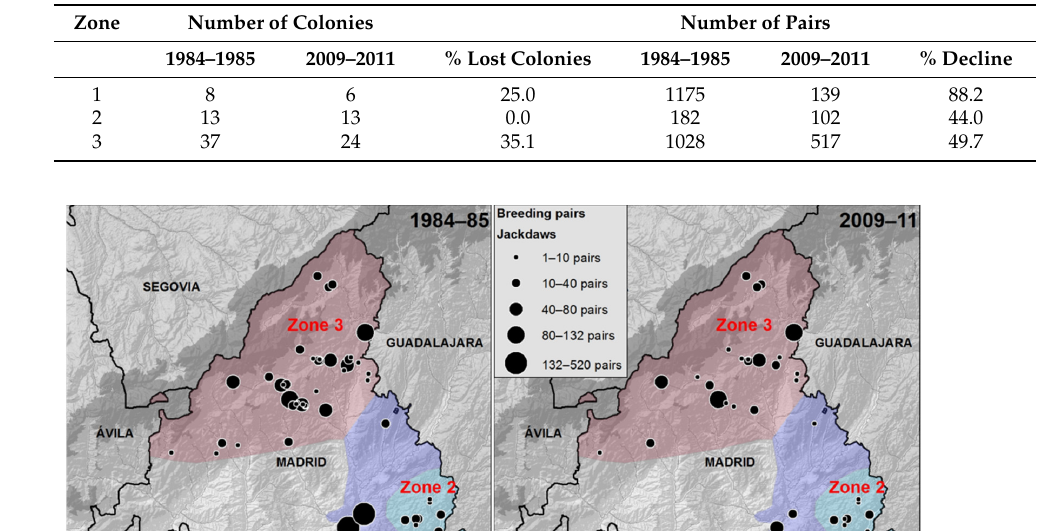
Table 2. Trends in the number of colonies and breeding pairs of jackdaws in Madrid, central Spain. Data refers to changes considering the same sample of colonies censused in 1984–1985 [61] and re-sampled in 2009–2011 (this study). Zone refers to the geographical areas specified in Figure 1.